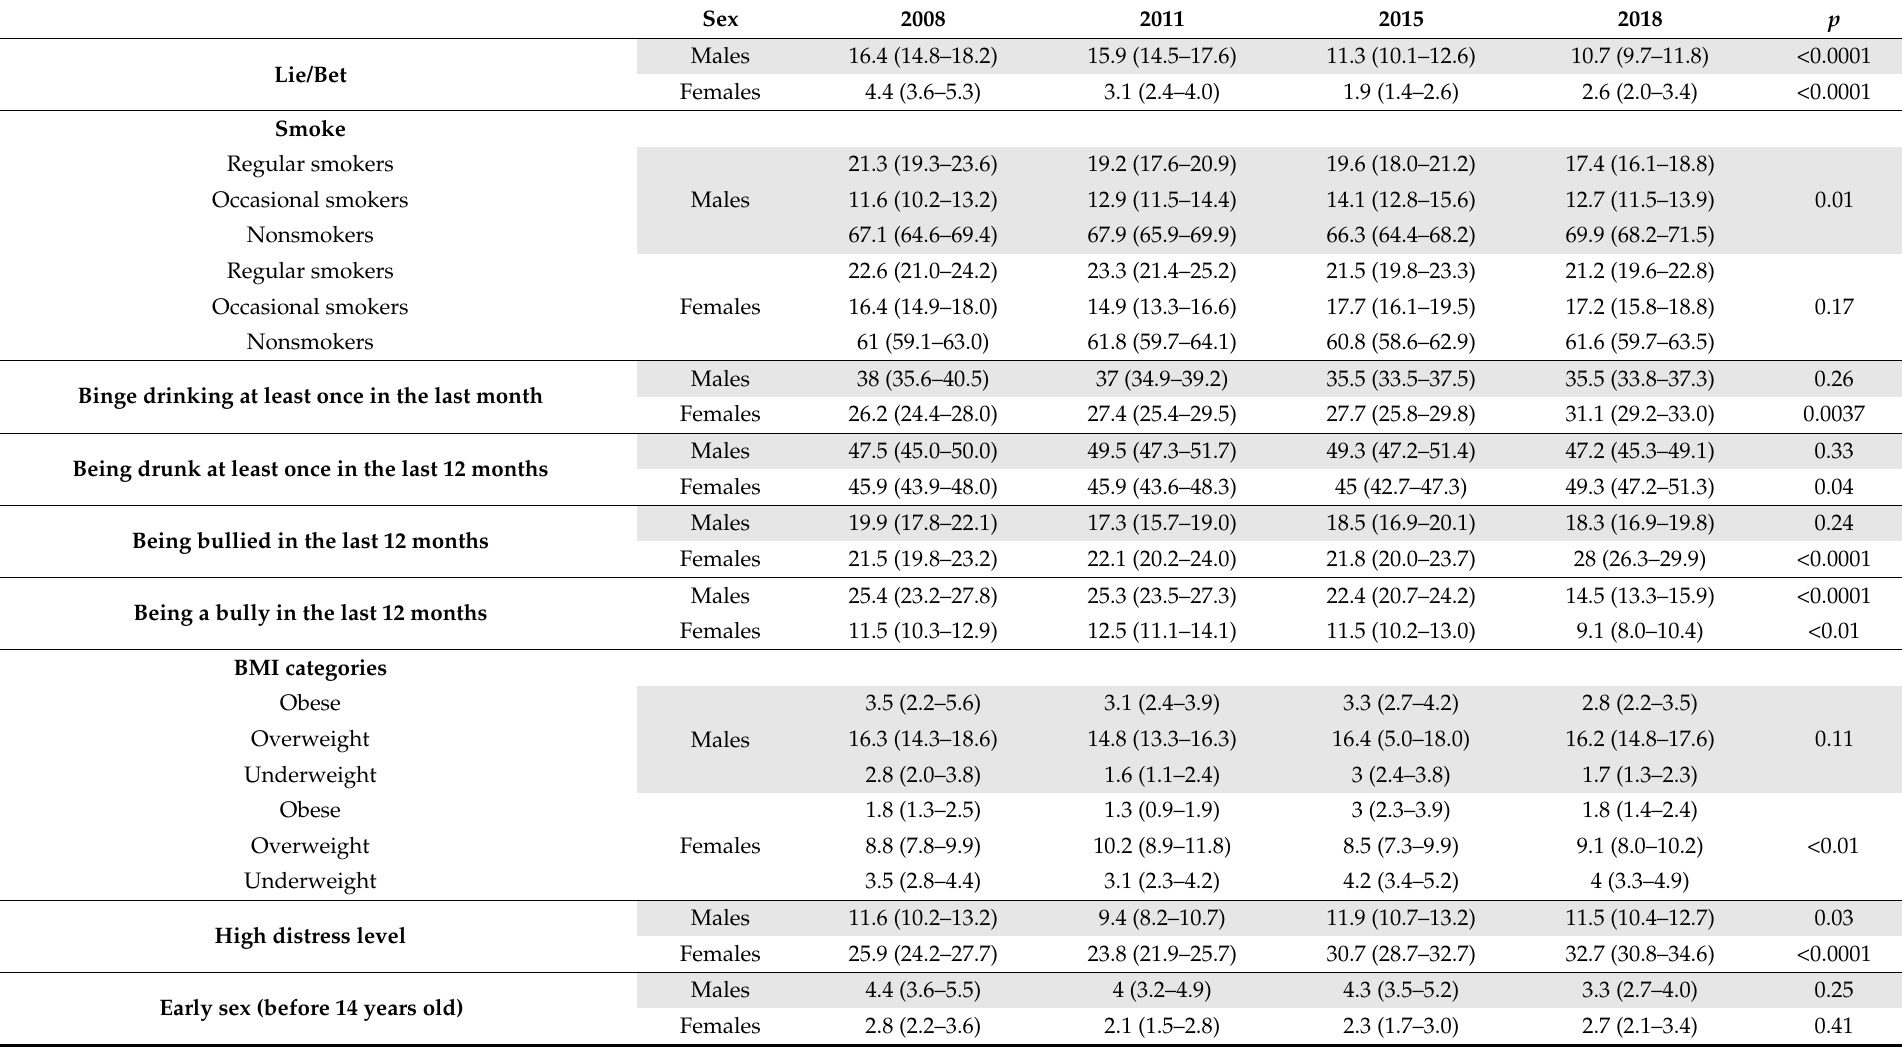
Table 3. Trends of the prevalence of health risk behaviors and health conditions by sex (survey waves 2008, 2011, 2015, and